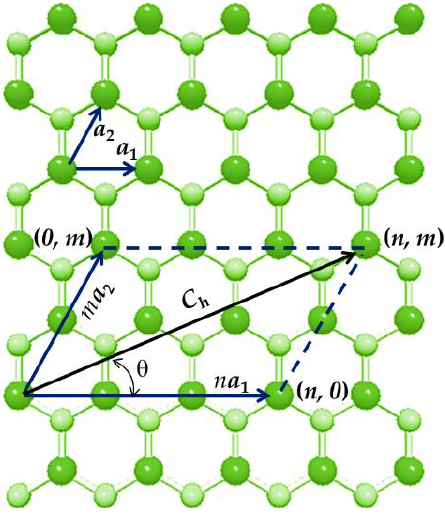
Figure 1. Representation of the hexagonal GaP lattice with designation of n and m, C h and θ . P atoms have a smaller radius and are represented in pale green and Ga atoms are in bright green.